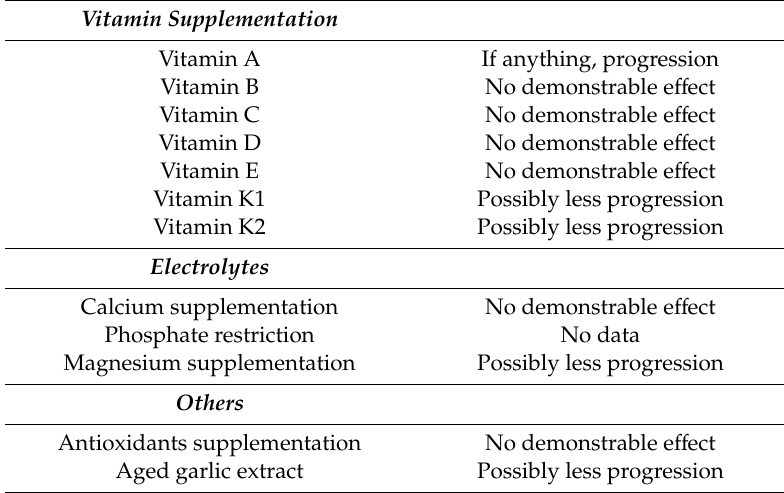
Table 2. E ff ect of nutritional interventions on vascular